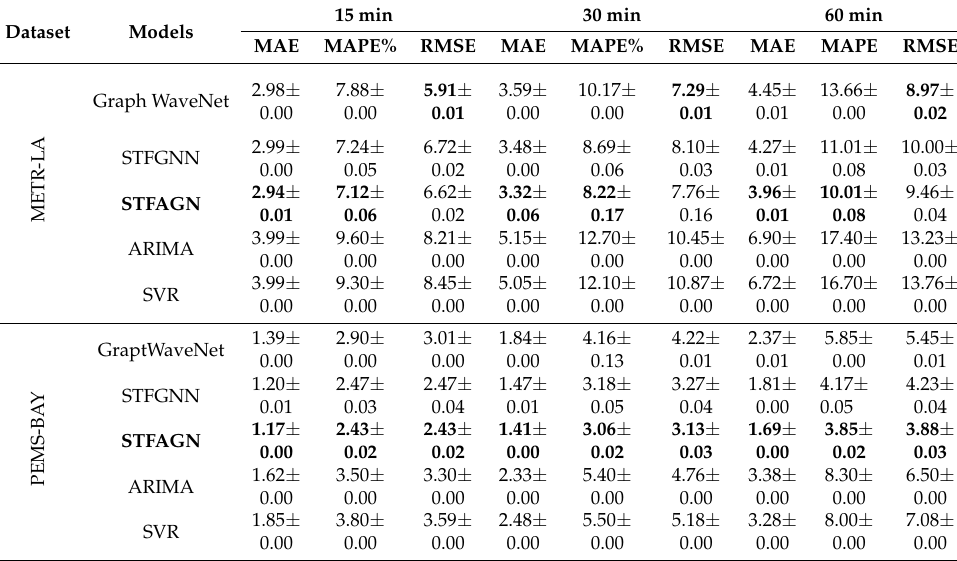
Table 2. Effectiveness and consequence of STFAGN in comparison with Graph WaveNet, STFGNN, ARIMA and SVR. We trained every models five times to get five results and calculated the mean and standard deviation of the